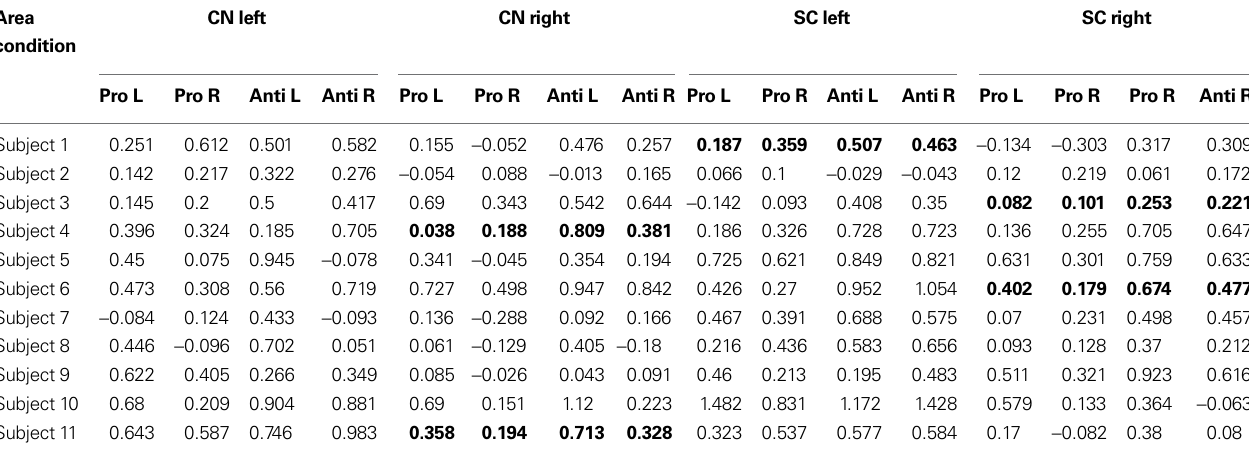
Table 2 | Fitted response amplitudes for FEF zones projecting to either SC or CN and for each condition, for all individual subjects. Due to connections that could not be established (at most 1 per subject, otherwise subject would have been excluded), some of the data had to be estimated (inputted; see Materials and Methods). Estimated values are depicted in bold.